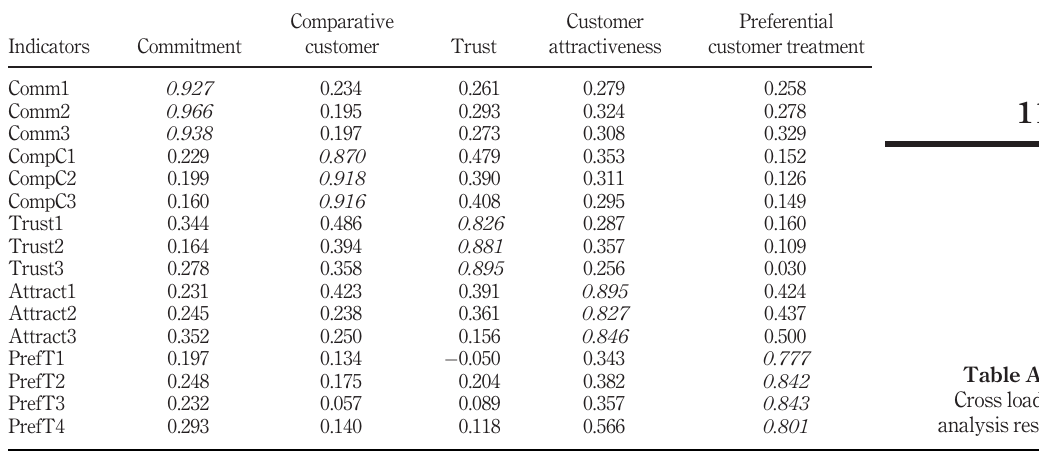
Table AIII. Cross loading analysis